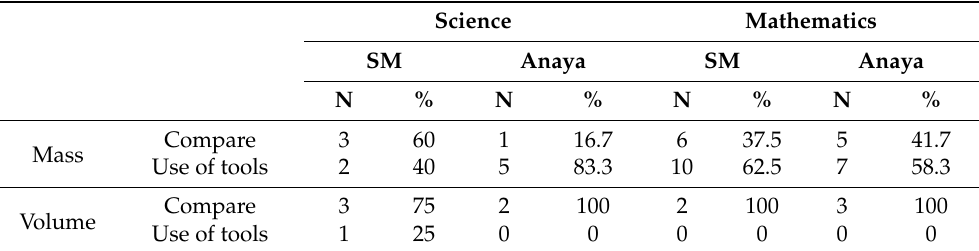
Table 4. Comparison skills by magnitude, subject and publisher.